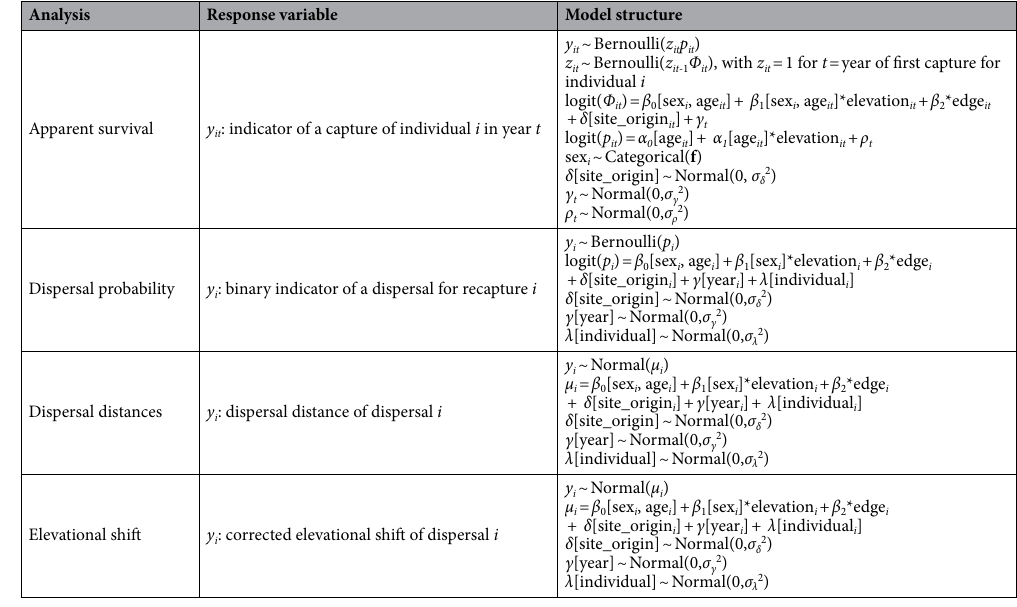
Table 4. Description of the models conducted in this